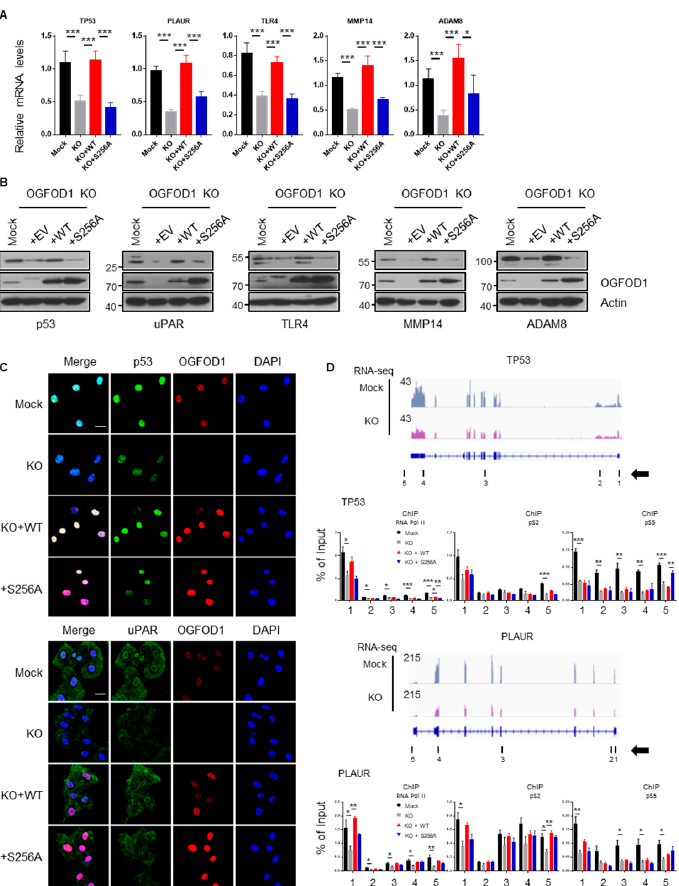
Figure 6. Analysis of genes affected by OGFOD1-knockout. ( A ) Relative mRNA levels in wild-type or mutant (S256A) backup cell lines. Statistical data are presented as mean ± SD. Two-tailed unpaired Student’s t-test was conducted for statistical analysis ( n = 5) (* p < 0.05, ** p < 0.01, *** p < 0.001). ( B ) Protein levels of downregulated genes in OGFOD1 backup cell lines. ( C ) Immunofluorescence images of target genes. Target proteins were stained with indicated antibodies and Alexa 488 (green). OGFOD1 was stained with Alexa 568 (red), and nuclei were stained with DAPI (blue); scale bar indicates 20 μ m. ( D ) Chromatin immunoprecipitation assay on target genes using the indicated antibodies to determine if RNA polymerase II accumulation was affected following OGFOD1 KO or phosphorylation. Measured sites are indicated with black bars and numbers. Arrow indicates gene orientation.